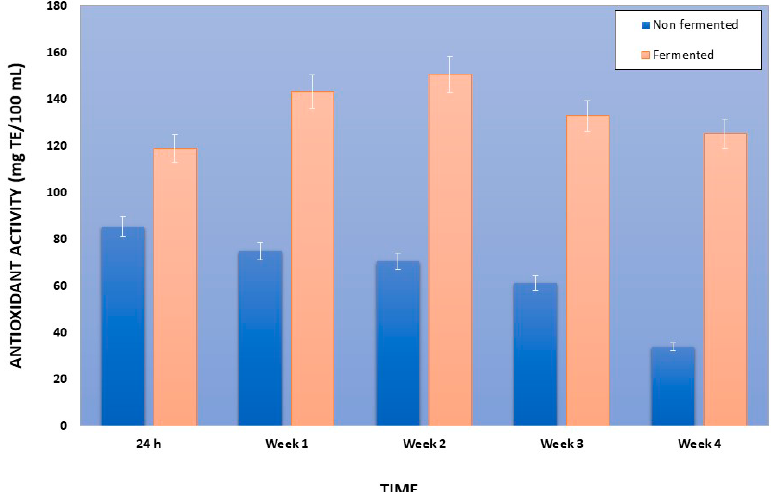
Figure 2. Antioxidant activity of fermented with Lactobacillus plantarum ATCC 14917 and non-fermented pomegranate juice and at first 24 h at 30 °C and during storage at 4 °C for 4 weeks. TE, Trolox equivalent.